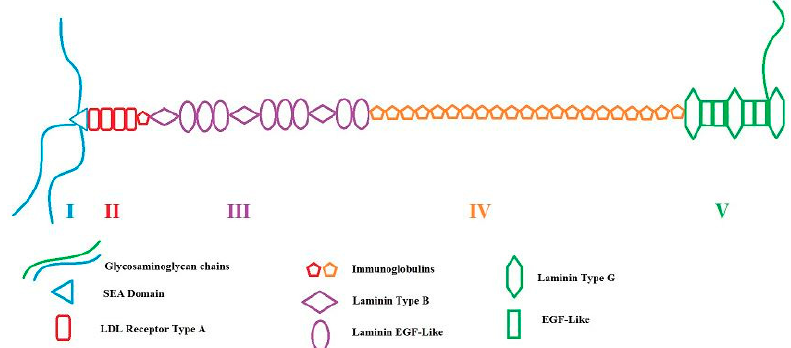
Figure 1. Representation of human heparan sulfate proteoglycan 2 (HSPG2)/perlecan proteoglycan